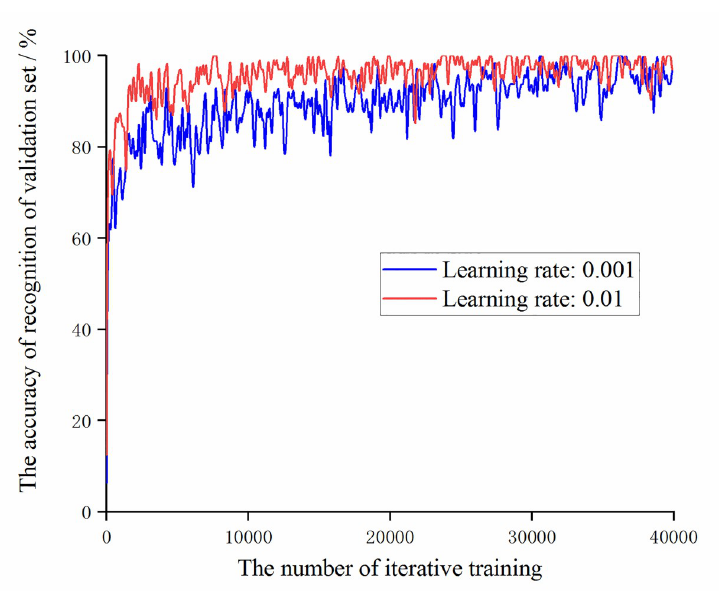
Fig 11. The trend of the accuracy of the validation set with the number of iterative training at learning rates of 0.001 and 0.01.